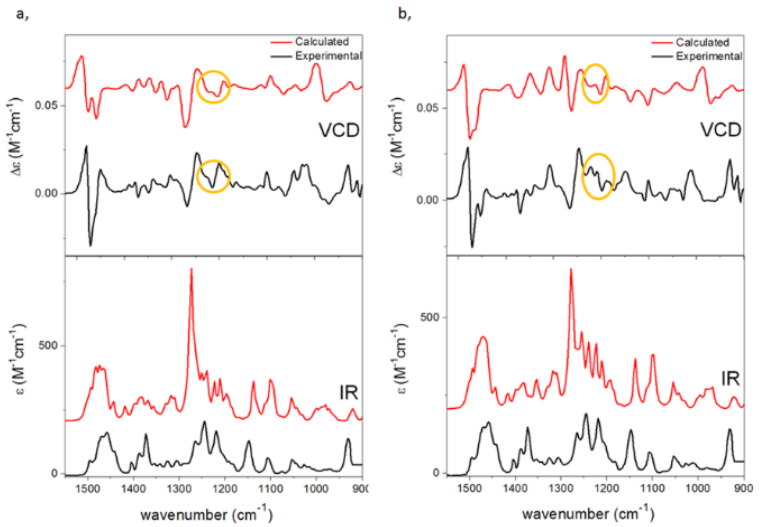
Figure 6. Experimental VCD (upper black, in CDCl 3 ) and IR spectra (lower black, in CDCl 3 ) of ( a ) (5 S ,1 ′ S ) ‐ 1a and ( b ) (5 S ,1 ′ R ) ‐ 1b compared with the B3LYP/TZPV PCM/CHCl 3 VCD (upper red) and IR (lower red) spectra. Characteristic VCD transitions reflecting the different C ‐ 1 ′ ACs were highlighted with yellow circles.